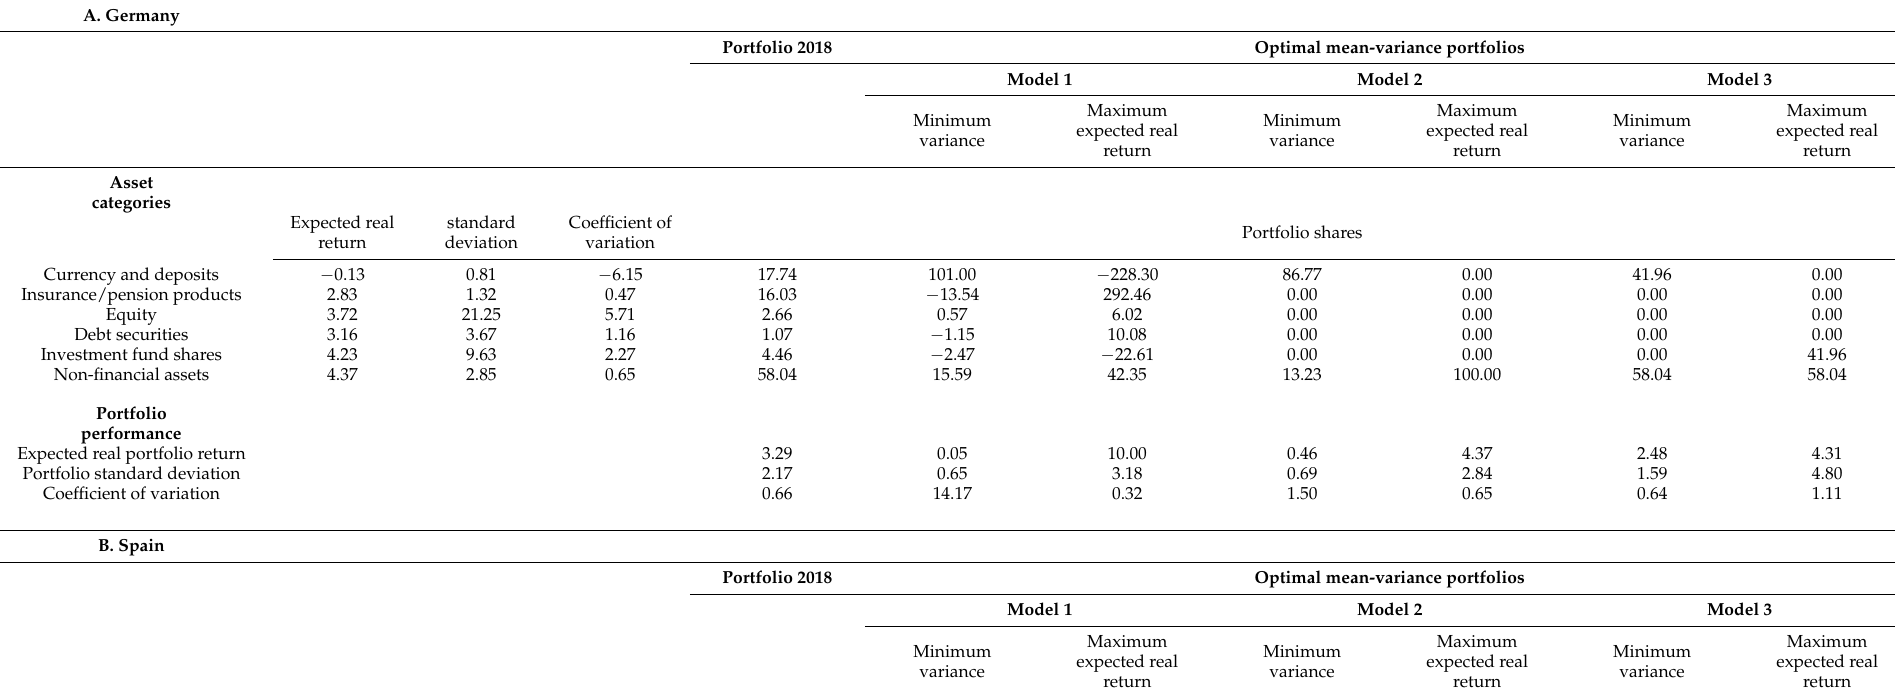
Table 4. Minimum variance and maximum expected real return